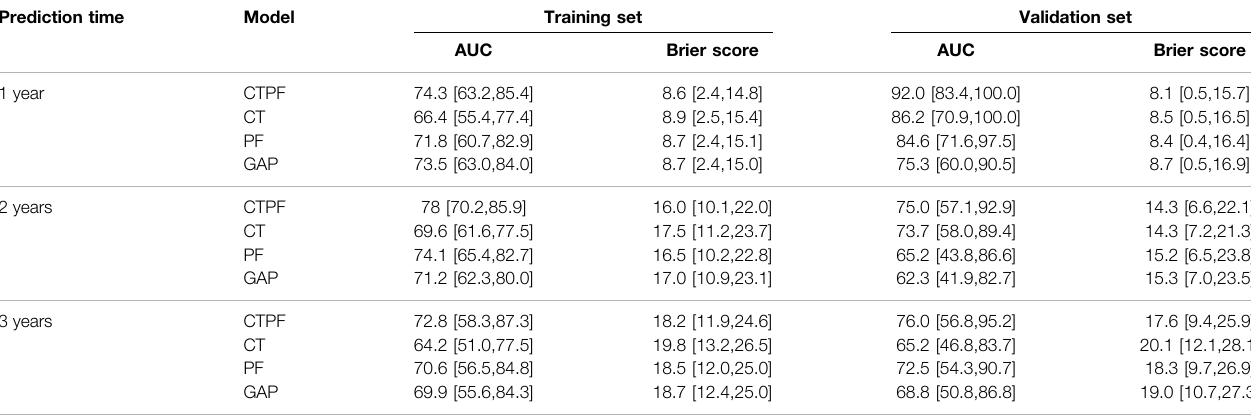
TABLE 5 | Discrimination of different models in the training and validation cohort. Prediction time